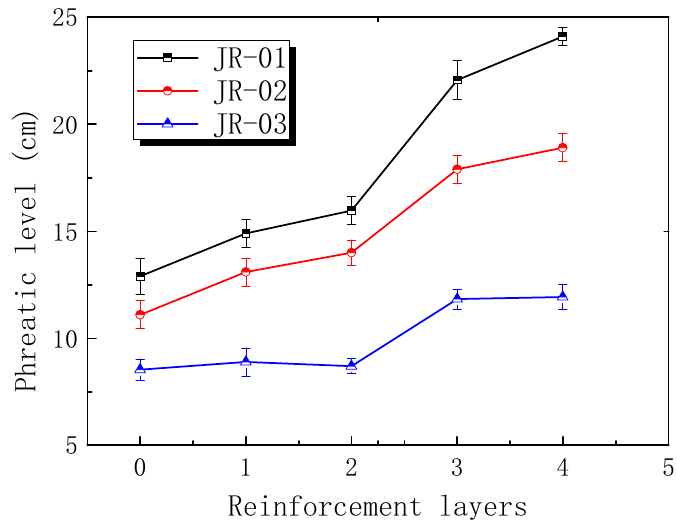
Figure 8. Final phreatic level at the end of time.